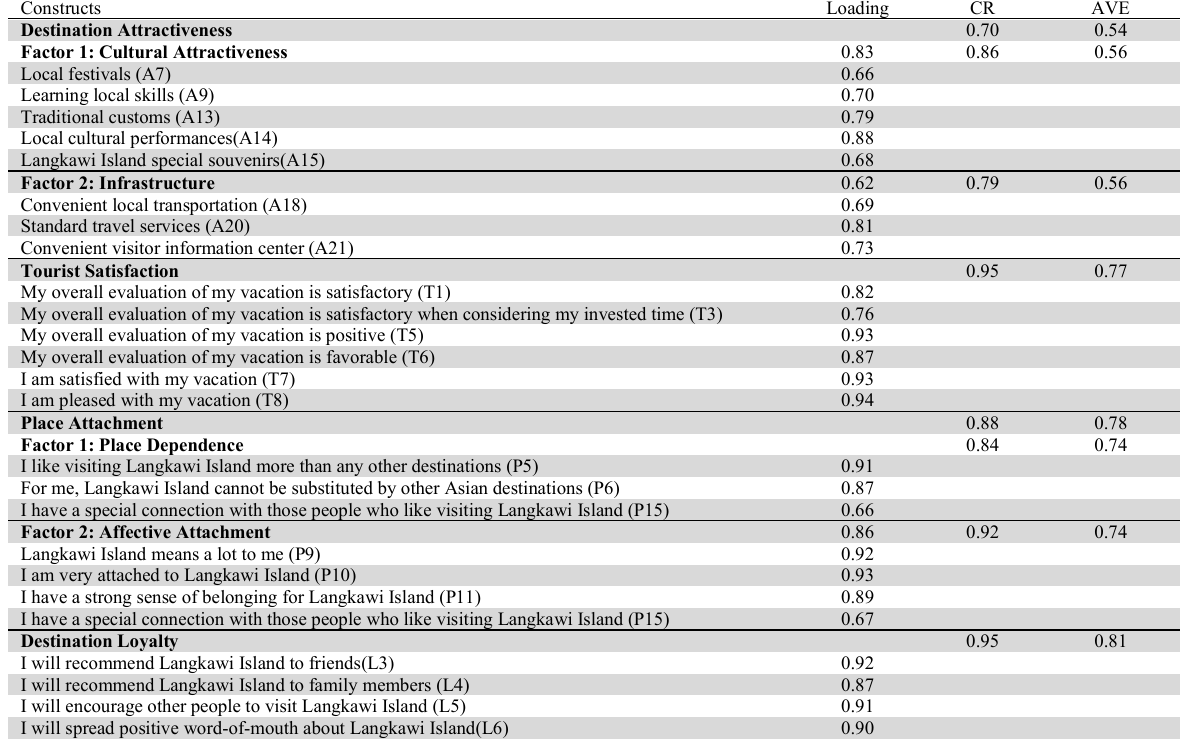
Factor Loading, Composite Reliability and Average Variance Extracted Constructs